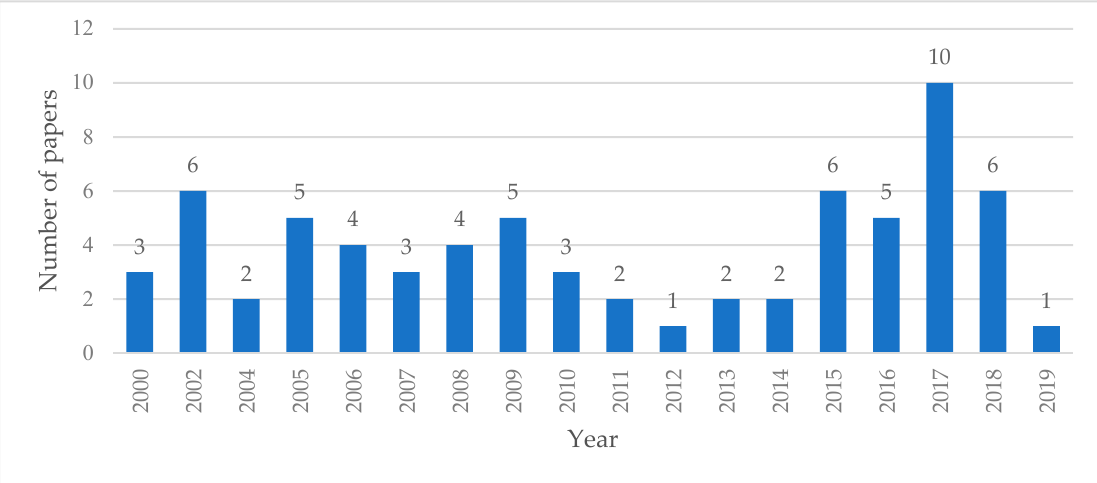
Figure 3. Yearly CTS publications.